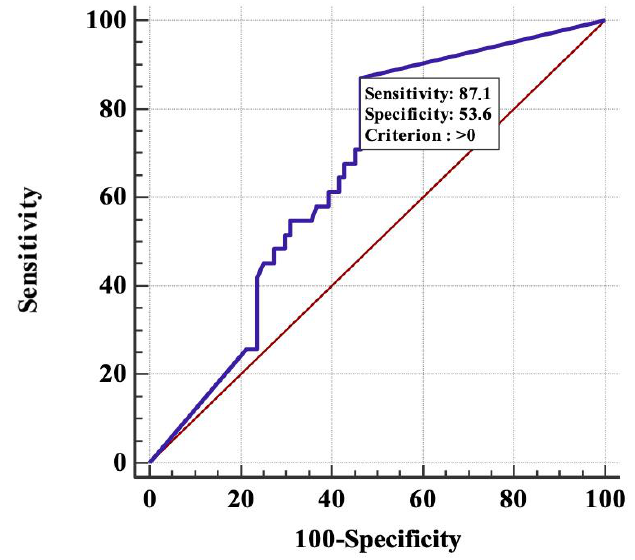
Figure 3. ROC-curve, built on the basis of data on the degree of integration of HPV 16/18 DNA into the cell genome (from 0% in the absence of integration to 100% in the case of complete inte-